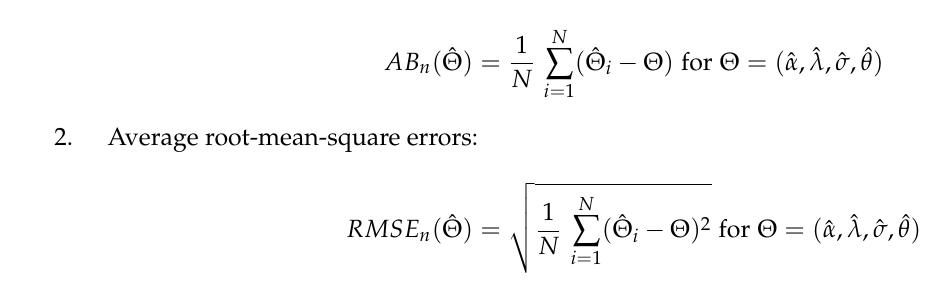
Coverage probability: percentage of confidence intervals containing the true value of Θ at the 95% confidence